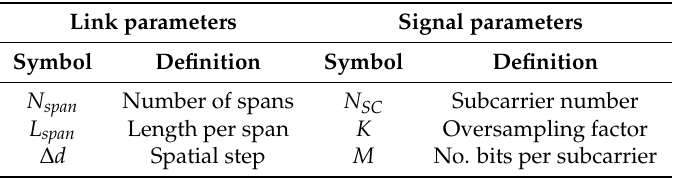
Table 2. Parameters employed in the calculation of